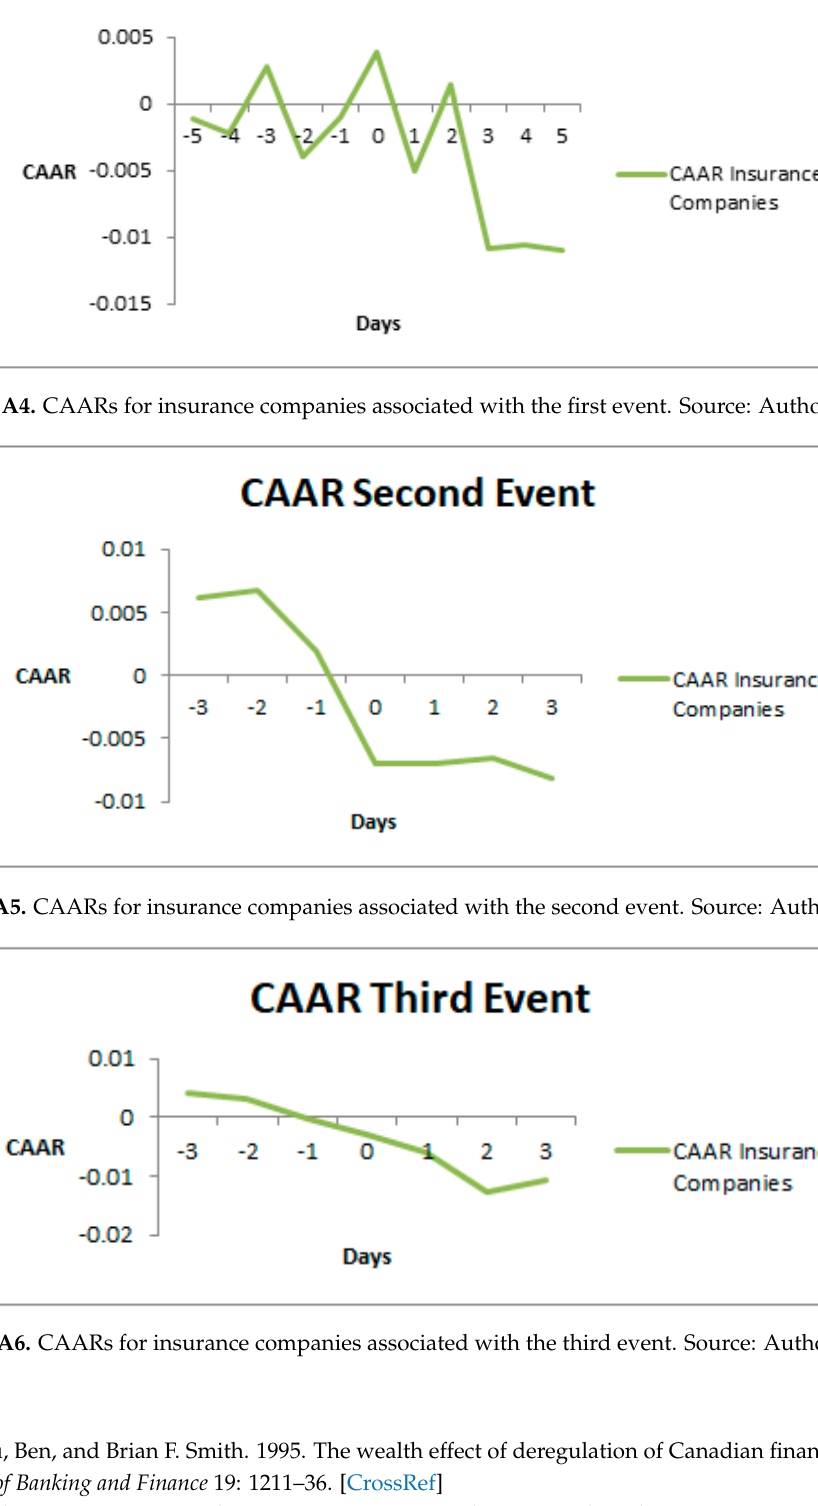
Figure A6. CAARs for insurance companies associated with the third event. Source: Authors’ work.